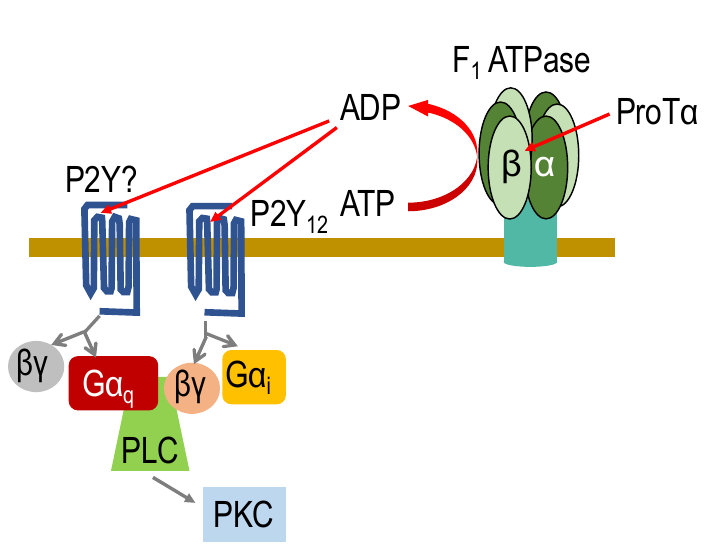
Figure 4. Putative ProT α -receptor complex. ProT α receptor (ProT α -R) complex comprises an ecto-F 1 ATPase, a G i -coupled P2Y 12 receptor, and an unidentified G q -coupled P2Y receptor, based on ProT α increasing the ATPase activity of the recombinant F 1 ATP5A1/5B complex. In this model, the source of ATP remains elusive. The discussion of an alternative source of ADP in relation to ecto-F 1 ATPase activity is described in the text.